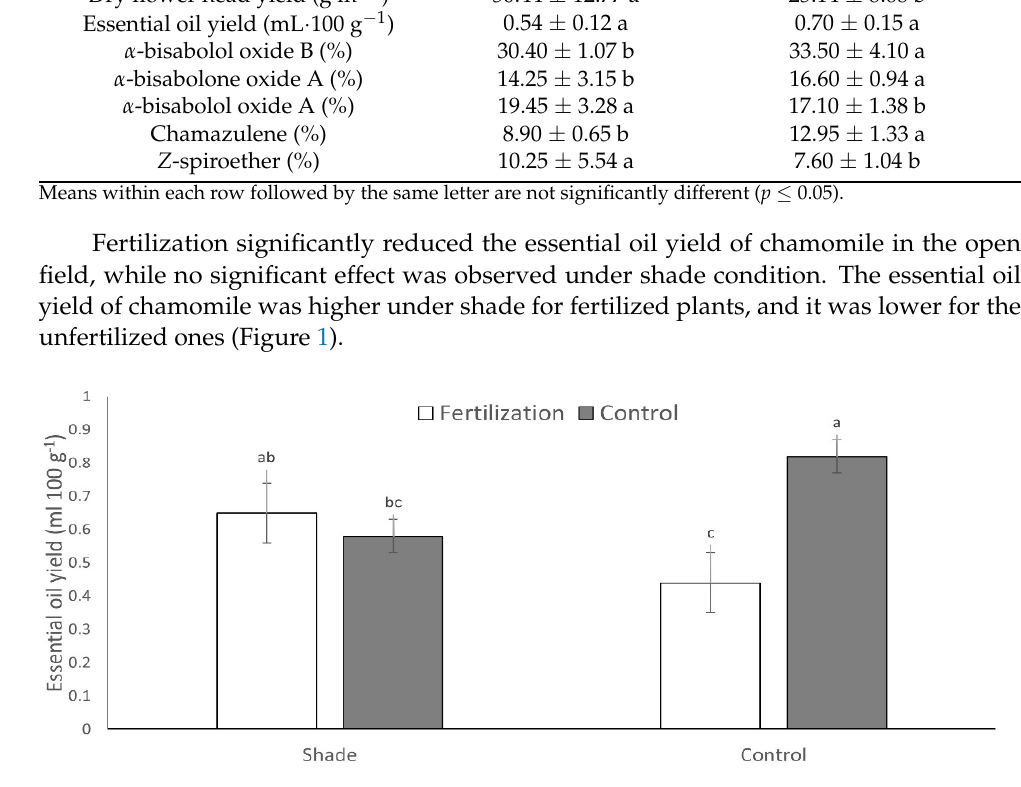
Table 5. Effects of shading and fertilizer application on the essential oil major components (mean ± SD) of chamomile.